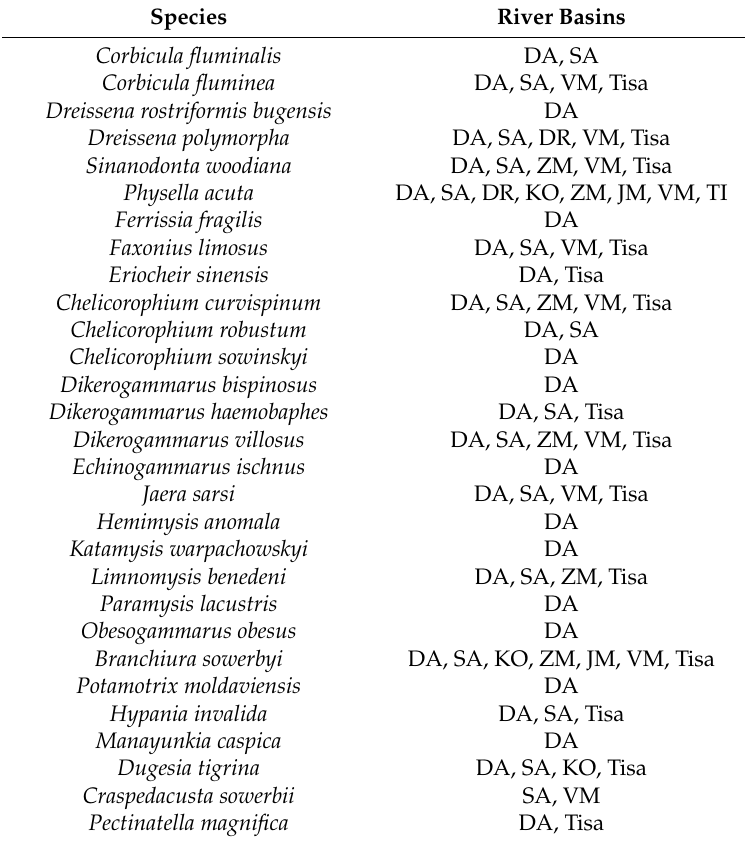
Table 4. Current distribution of allochthonous macroinvertebrate species in Serbian major river basins. Abbreviations: DA–Danube, SA–Sava, DR–Drina, KO–Kolubara, ZM–Zapadna Morava, JM–Južna Morava, VM–Velika Morava, TI–Timok, Tisa–Danube